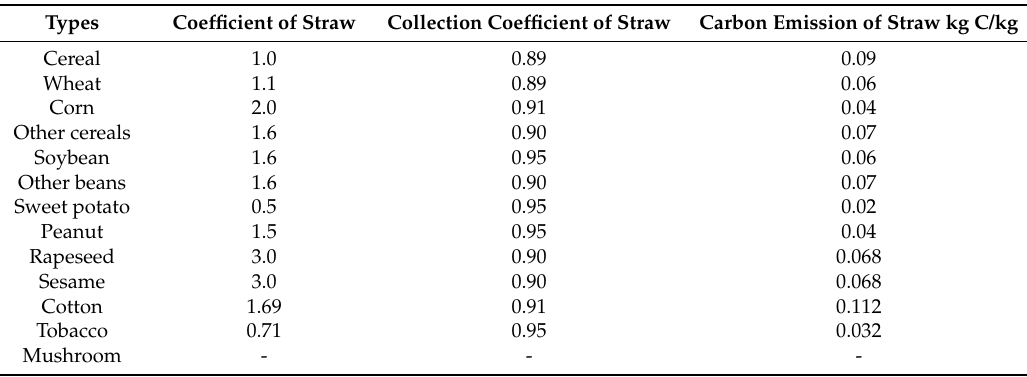
Table 2. Straw combustion